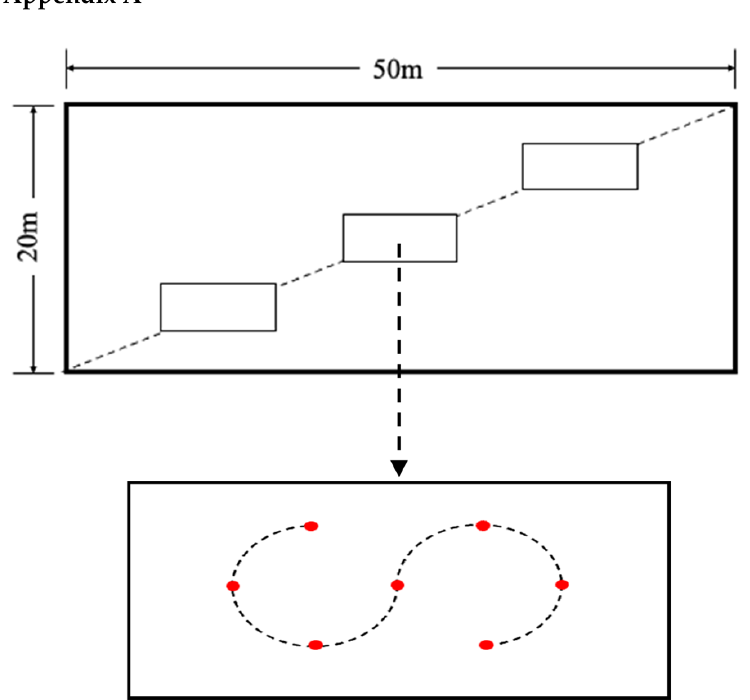
Figure A1. Sampling design at sample sites of different elevations. Three rectangles are sampling points set along the diagonal of the 20 m × 50 m sample plot. Red dots show the distribution where mixed sampling was performed.